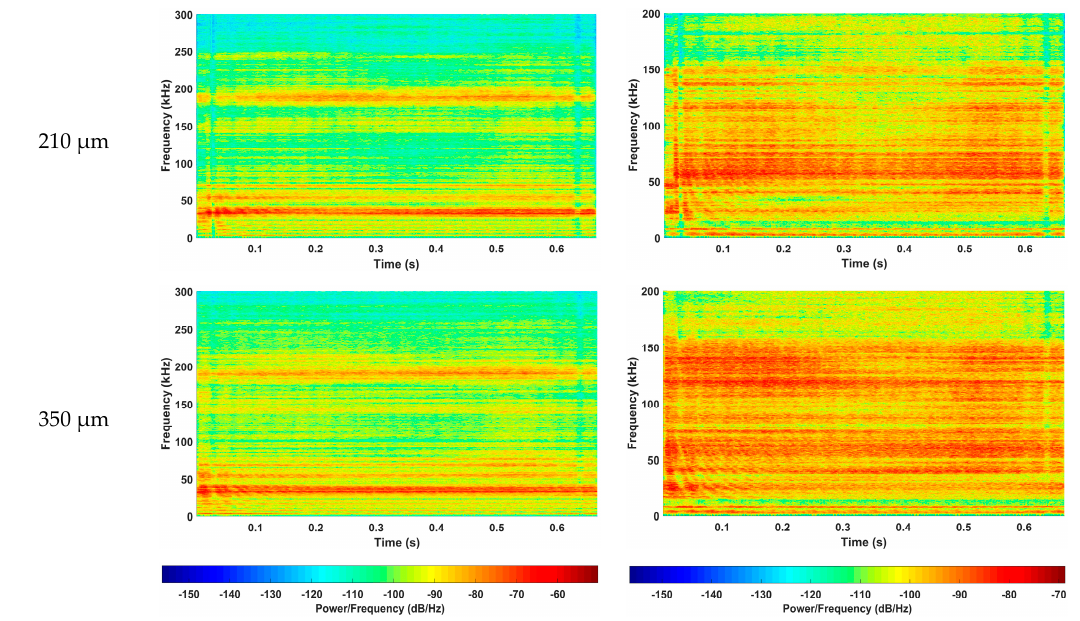
Figure 4. Short-time Fourier transform (STFT) spectrograms. Sensors 2019 , 19 , x FOR PEER REVIEW